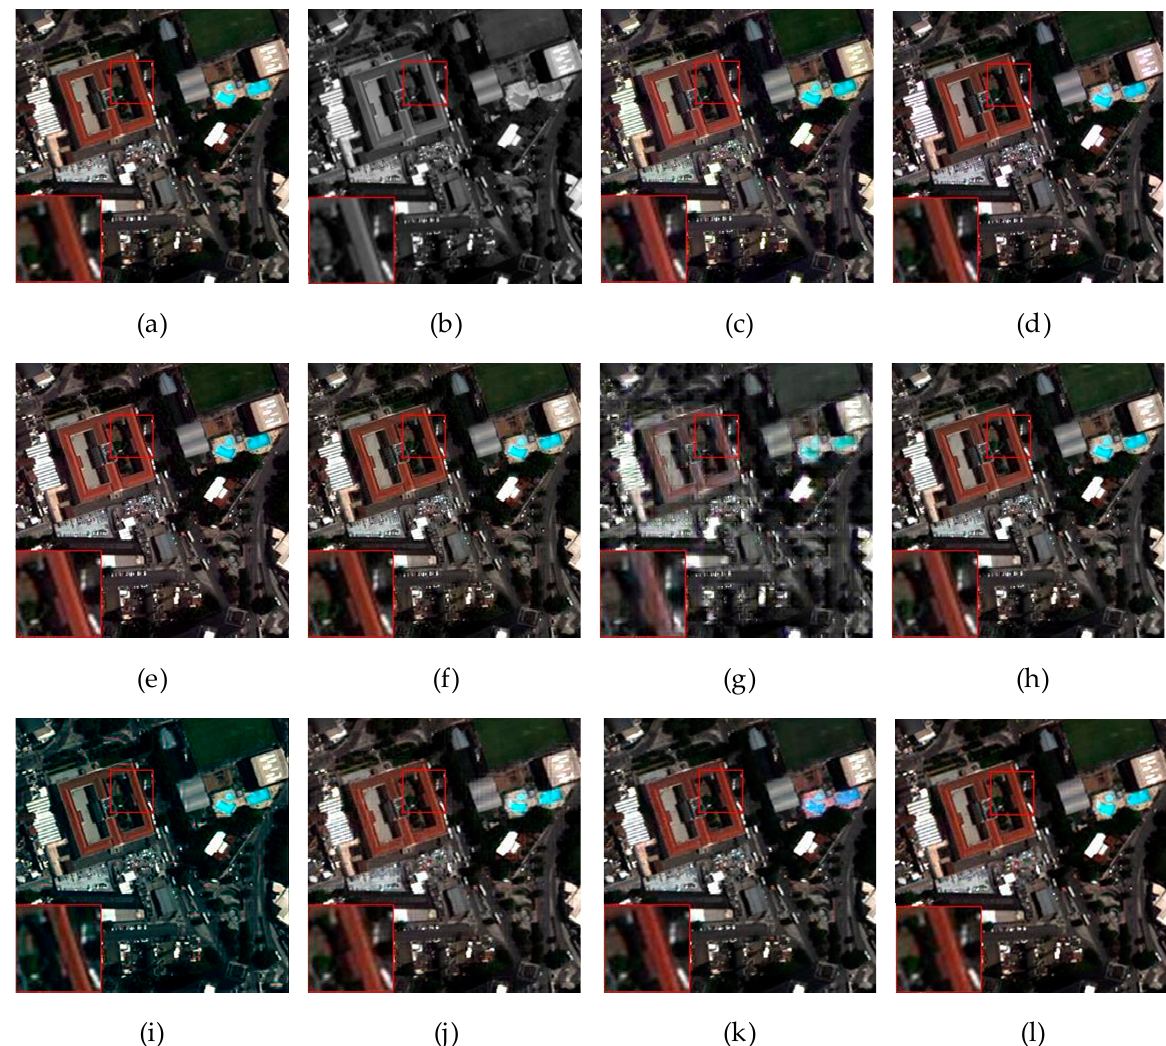
Figure 8. Results of the WorldView ‐ 3 dataset with four bands and 256 × 256 size. ( a ) Reference image; ( b ) panchromatic (PAN) image; ( c ) intensity ‐ hue saturation (IHS); ( d ) partial substitution (PRACS); ( e ) Gram–Schmidt (GS); ( f ) HPF; ( g ) multi ‐ resolution analysis ‐ based method DWT; ( h ) multi ‐ resolution analysis ‐ based method GLP; ( i ) model ‐ based method SIRF; ( j ) CNN ‐ based method PanNet; ( k ) CNN ‐ based method PSGan; ( l ) MDECNN.